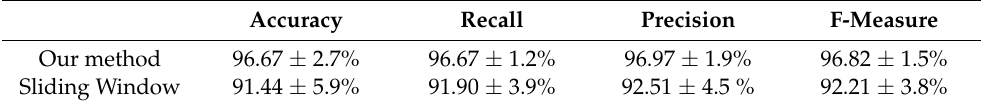
Table 2. Performance comparison using accuracy, recall, and precision measures (mean ± standard deviation) between segmentation using the proposed method and fixed-size sliding window.